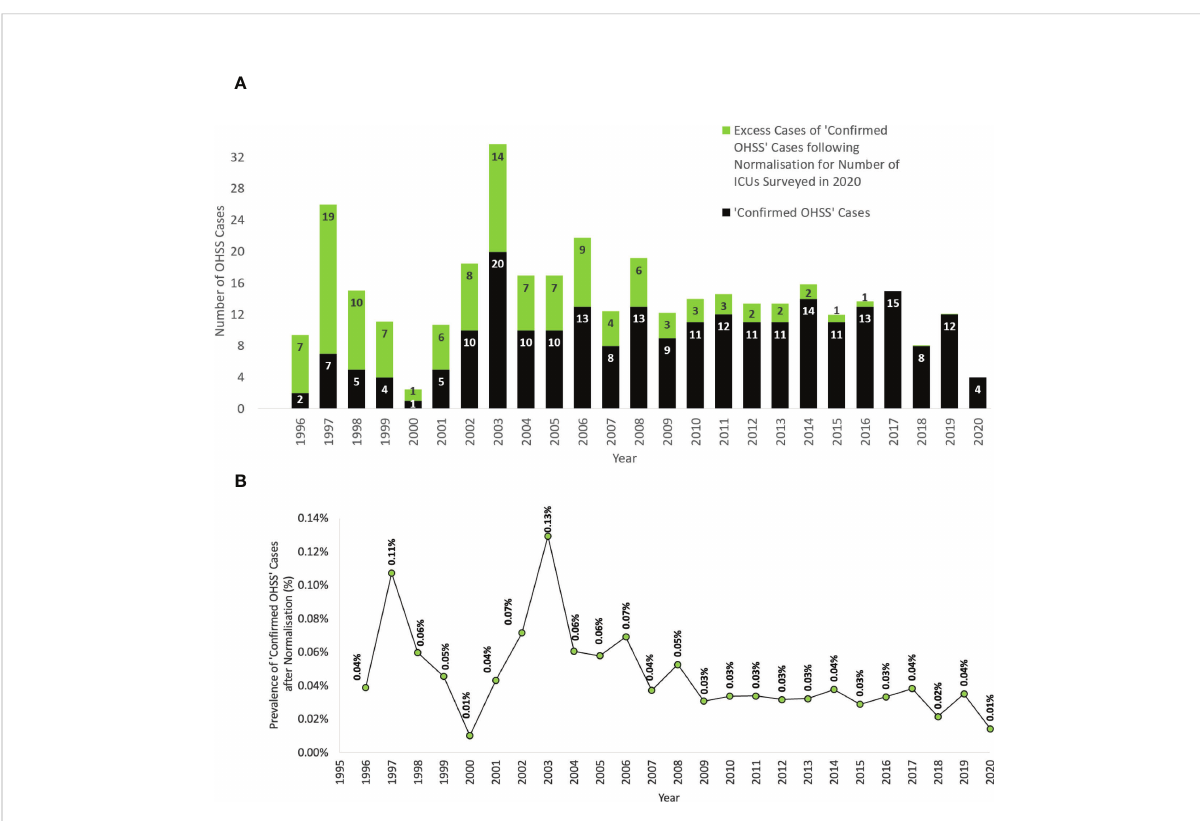
ICU with ‘ con fi rmed ’ and ‘ without OHSS ’ are presented in Table 2. The ‘ lowest systolic blood pressure ’ in patients with ‘ con fi rmed OHSS ’ was higher than in patients ‘ without OHSS ’ (P<0.0001), however there was no evidence for a statistically signi fi cant difference in the ‘ highest systolic blood pressure ’ between the groups (P=0.11). Patients with ‘ con fi rmed OHSS ’ , had higher heart rate (both lowest recorded heart rate, P<0.0001; and highest recorded heart rate, P=0.02) and increased non- ventilated respiratory rate (lowest non-ventilated, P<0.0001; highest non-ventilated, P=0.009) compared to patients ‘ without OHSS ’ . Both serum creatinine (lowest serum creatinine, P=0.005; highest serum creatinine, P=0.0003) and urea (P<0.0001) were